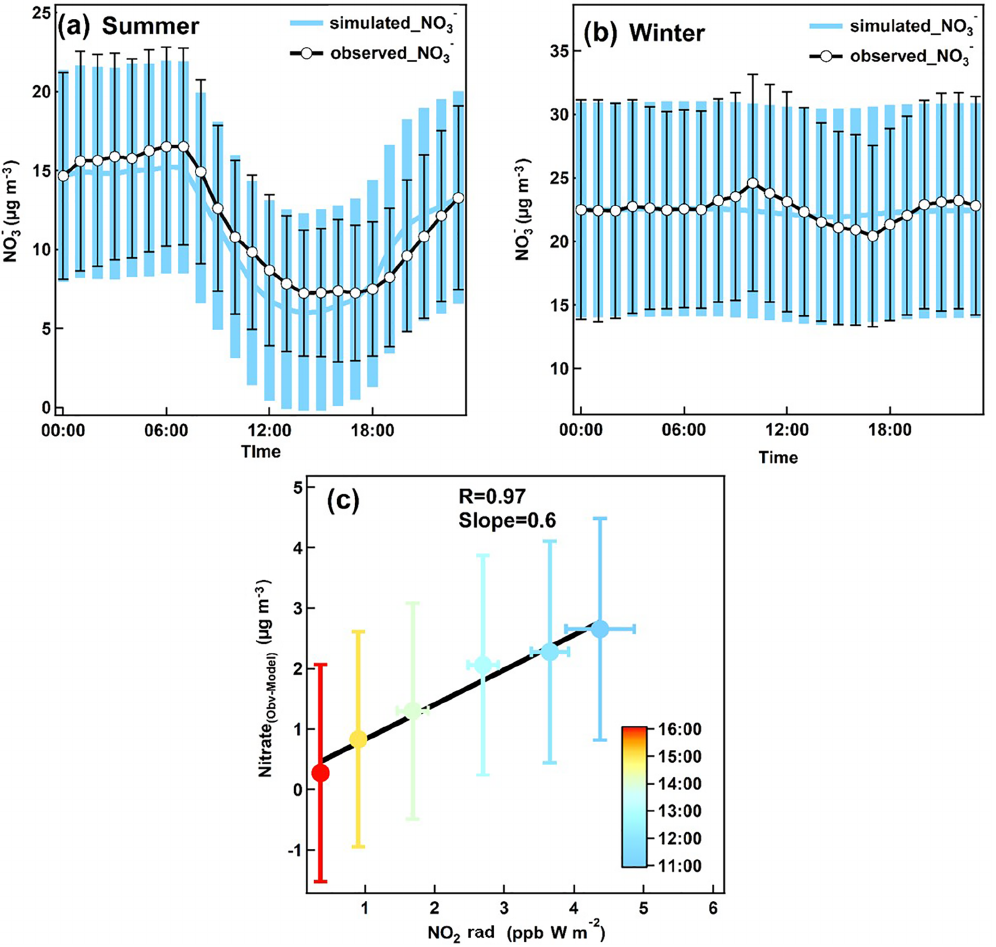
Figure 6. Modeled nitrate diurnal variations in (a) summer and (b) winter, together with the observed nitrate concentrations. Error bars provided are the standard deviation of the mean at each hourly interval. (c) Scatter plot of the difference between model and observed nitrate average mass concentrations with the product of NO 2 and radiation color coded by the hour of day for the